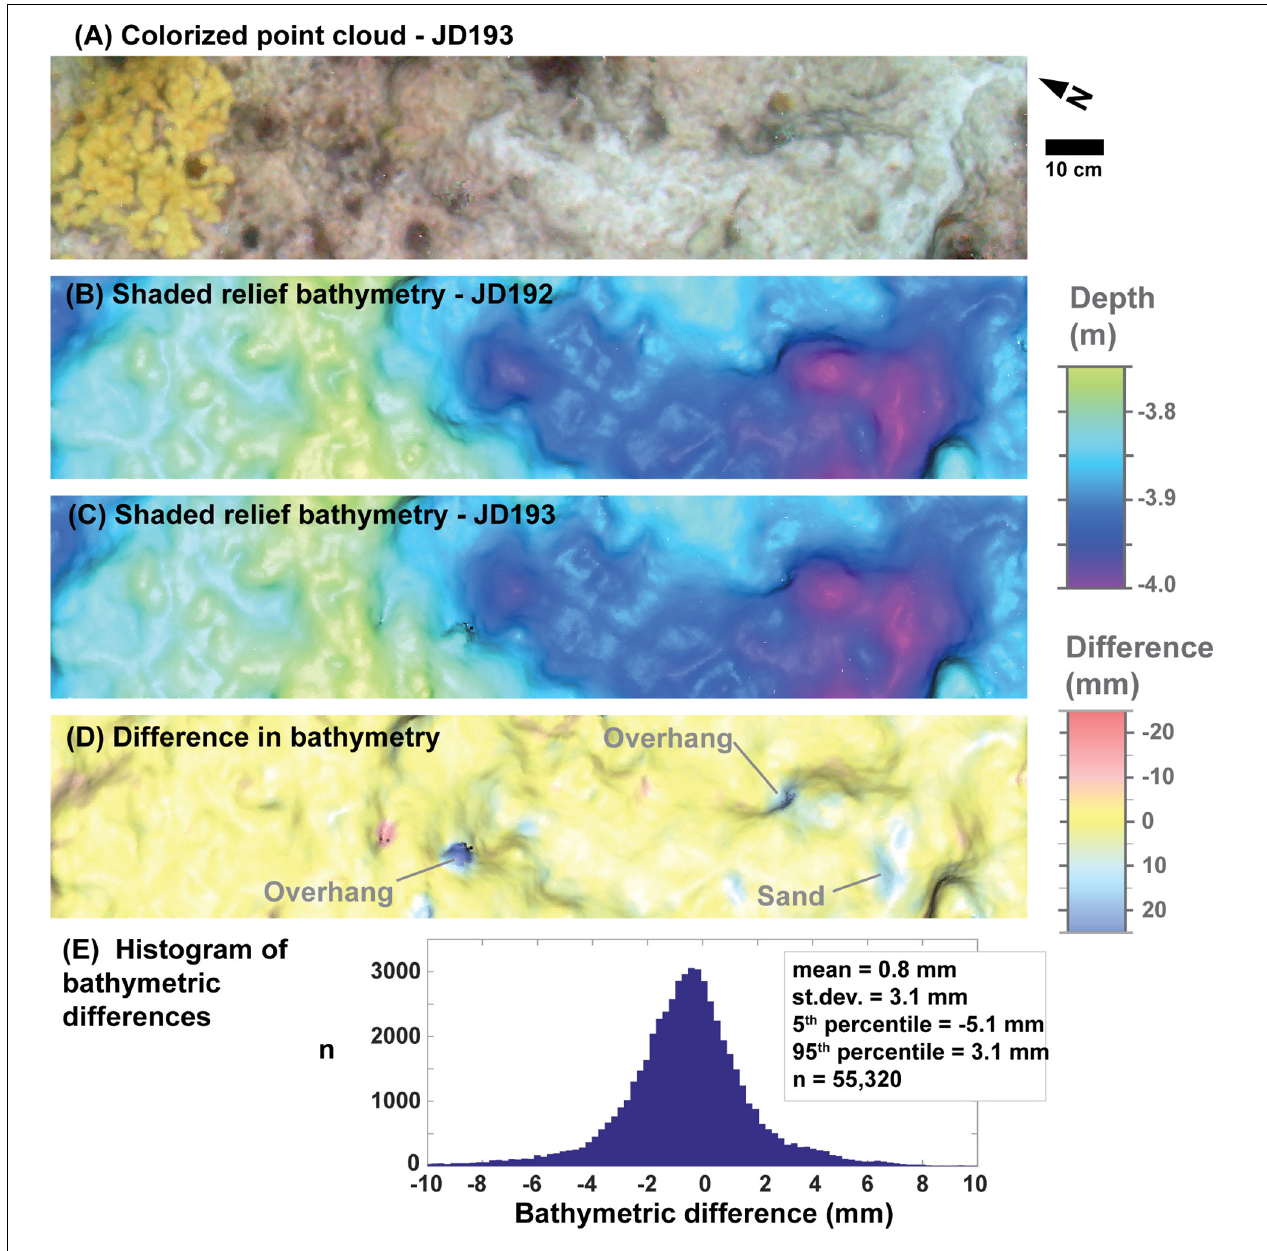
FIGURE 12 | Survey-to-survey differences for a 2 m by 0.4 m section of the Surface Elevation Table (SET) station 1 site reef chosen for its spatial complexity and lack of bryozoans. Location of this inset is shown in Figure 8 . (A) True color map of the point cloud showing live coral on the northern end of the transect and a depression with sand on the southern end. (B,C) Shaded relief of the bathymetric point clouds. (D) Difference between the two point clouds using the M3C2 measurement tool. Features with the greatest difference values are highlighted and described. (E) A histogram of the M3C2 difference measurements for this transect, including summary statistics of the